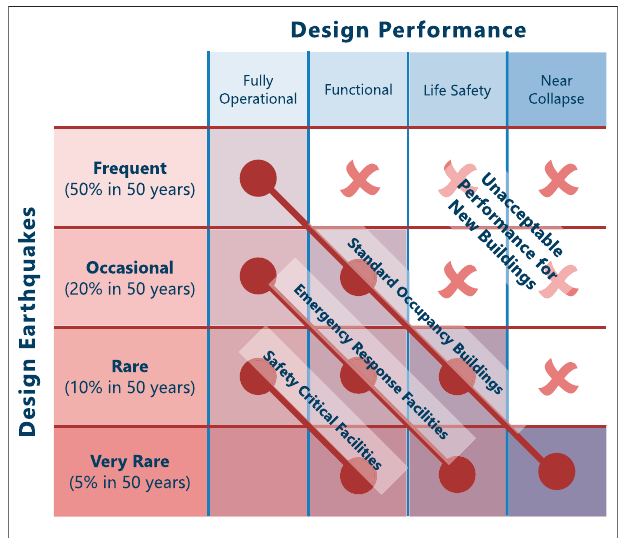
FIGURE 1 | Standard performance objectives, SEAOC ’ s Vision 2000 (Structural Engineers Association of California (SEAOC), 1995).